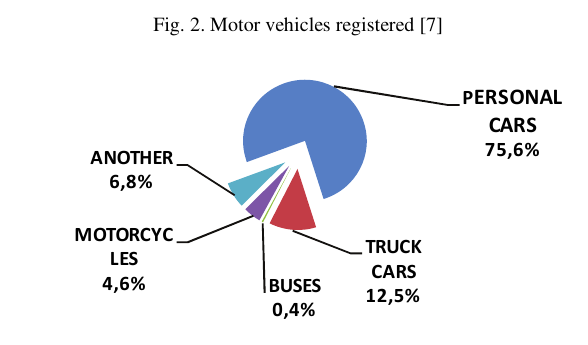
Fig. 2. Motor vehicles registered [7]